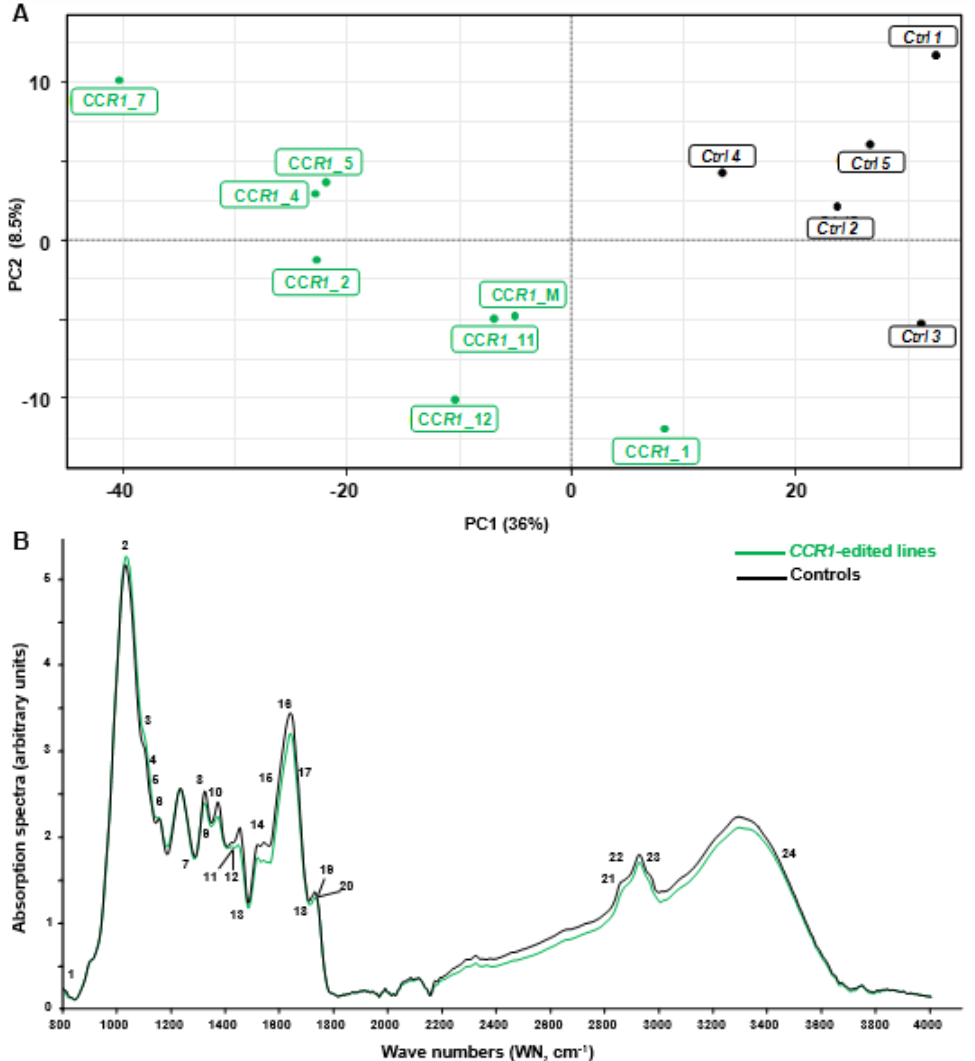
Figure 2. Comparison between FT-IR spectra obtained from controls and CCR1 edited lines. ( A ) partial least square analysis (PLS-DA) analysis was performed using the normalized values of Fourier-transformed infra-red (FTIR) absorption spectra (800–4000 cm − 1 ), acquired from hairy roots samples. The first principal component (PC) separates controls from CCR1 -edited lines and explains more than 36% of total variability. PC2 axis (8%) mostly explains the separation of different groups within CCR1 -edited lines. CCR1 _M represent a mixture of five CCR1 -edited samples ( CCR1_6, CCR1_8, CCR1_9, CCR1_10 and CCR1_13 ) due to not enough materials if proceeded individually. ( B ) FT-IR absorption spectra of controls (black) and CCR1 -edited lines (green). The curves were drawn using the median of controls and CCR1 -edited lines absorption values (except CCR1-1 and CCR1-14 ). Numbers 1–24 are the most significant wave numbers related to secondary cell wall polymers involved in the separation between controls and CCR1 -edited lines (see Supplementary Figure S1 and Supplementary Table S6) [33 – 43].